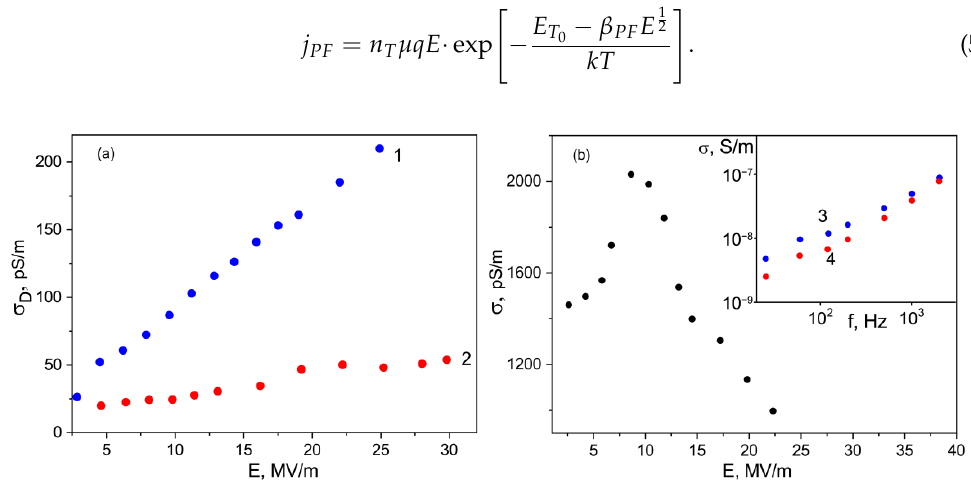
Figure 10. Field dependences of conductivities under a rectangular pulse of the electric field of the initial (( a ), 1), ZnTPP- (( a ), 2) and TPP-doped copolymer films ( b ) obtained from acetone; insert in Figure 10b: low-voltage conductivities of the films before (3) and after (4) high-voltage polarization.